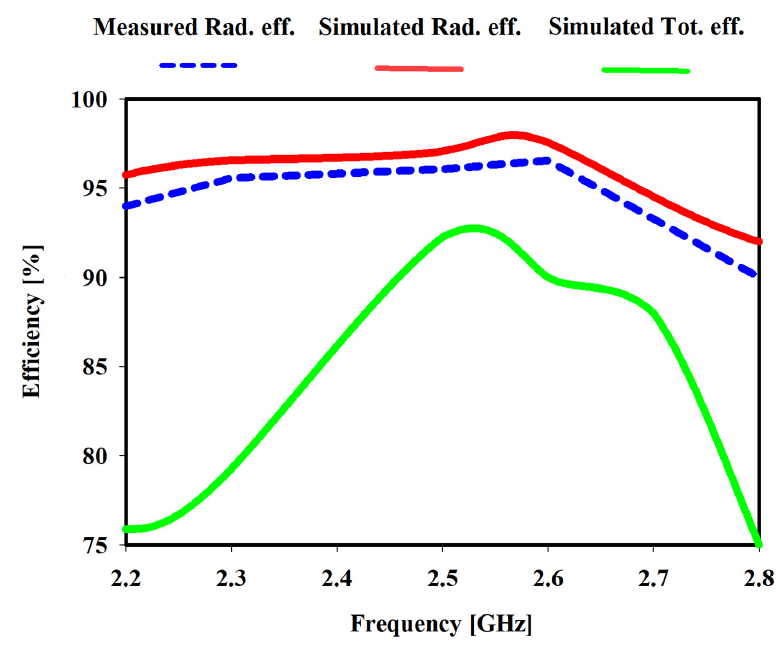
Figure 10. Simulated and measured efficiency of the proposed antenna .